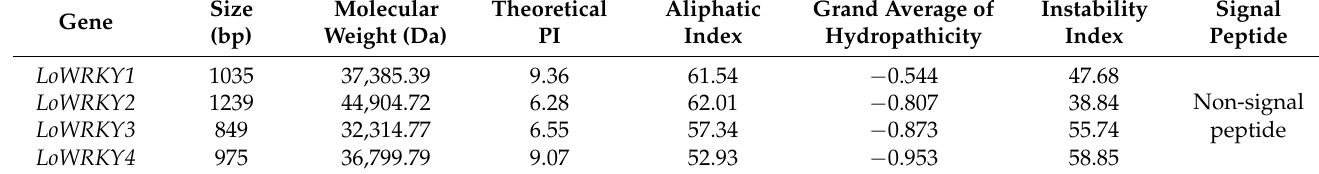
Table 4. Physical and chemical properties of WRKY transcription factor family genes in Larix olgensis .